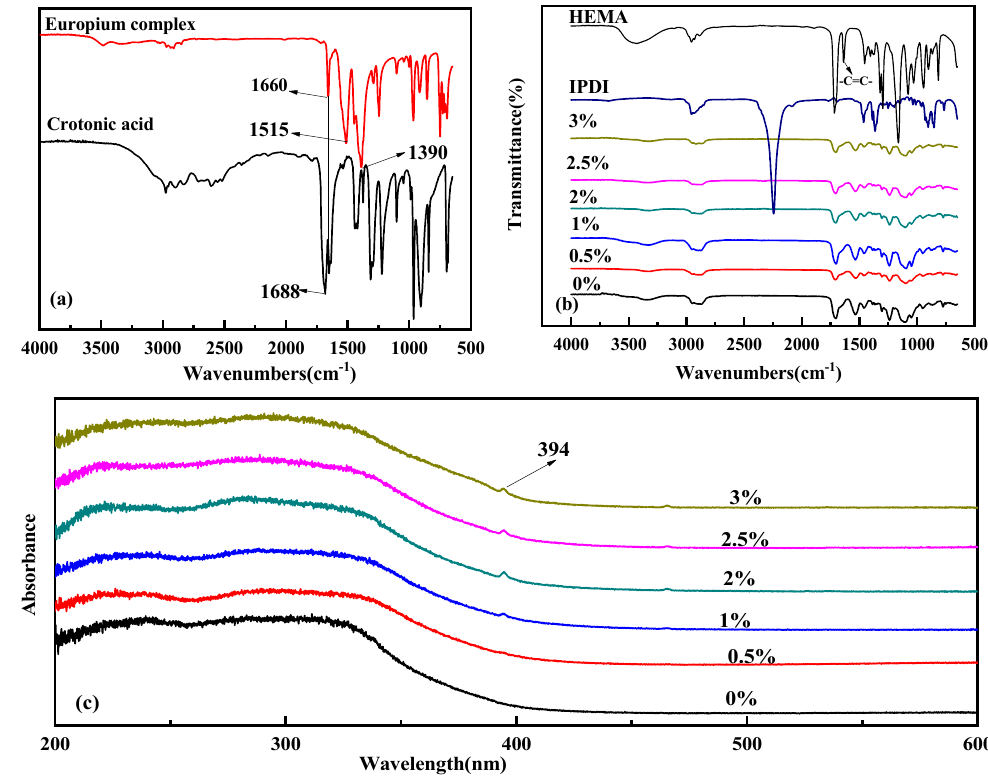
Figure 1. FTIR ( a , b ) and UV ( c ) spectra of the europium complex and polyurethane − europium materials with different mass contents of europium complex.